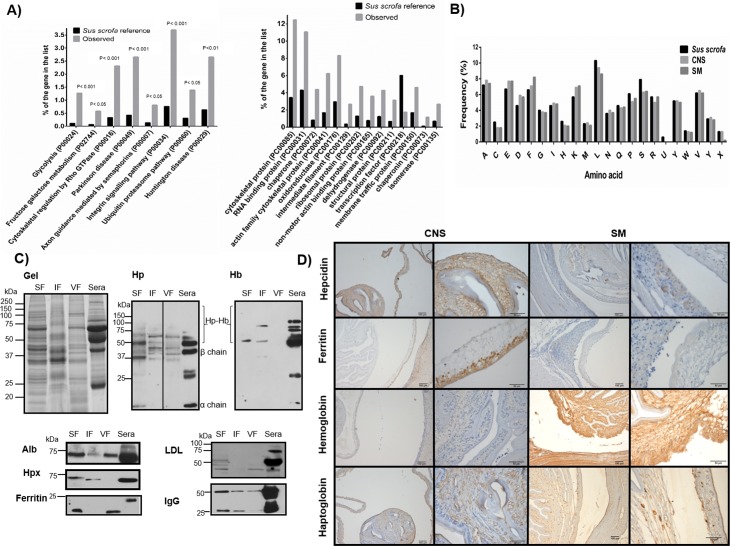
Annotation, composition and localization of host proteins in T. solium cysts.A) Significantly enriched host proteins in cysts extracts: metabolic pathways (categories with a P value<0.05) and molecular functions (categories with a P value <0.001). B) Amino acid composition of the host proteins associated with the central nervous system (CNS) and the skeletal muscle (SM) localization of the cysts (P value< 0.05), for comparison is shown the amino acid composition of the whole Sus scrofa proteome. C) Using specific antibodies several host proteins were identified in cyst’s protein extracts. D) Immuno-localization of host proteins related to iron metabolism in cysts obtained from the CNS and SM; scale bars in the first and third column of images correspond to 100 μM whereas in the second and fourth columns correspond to 50 μM.